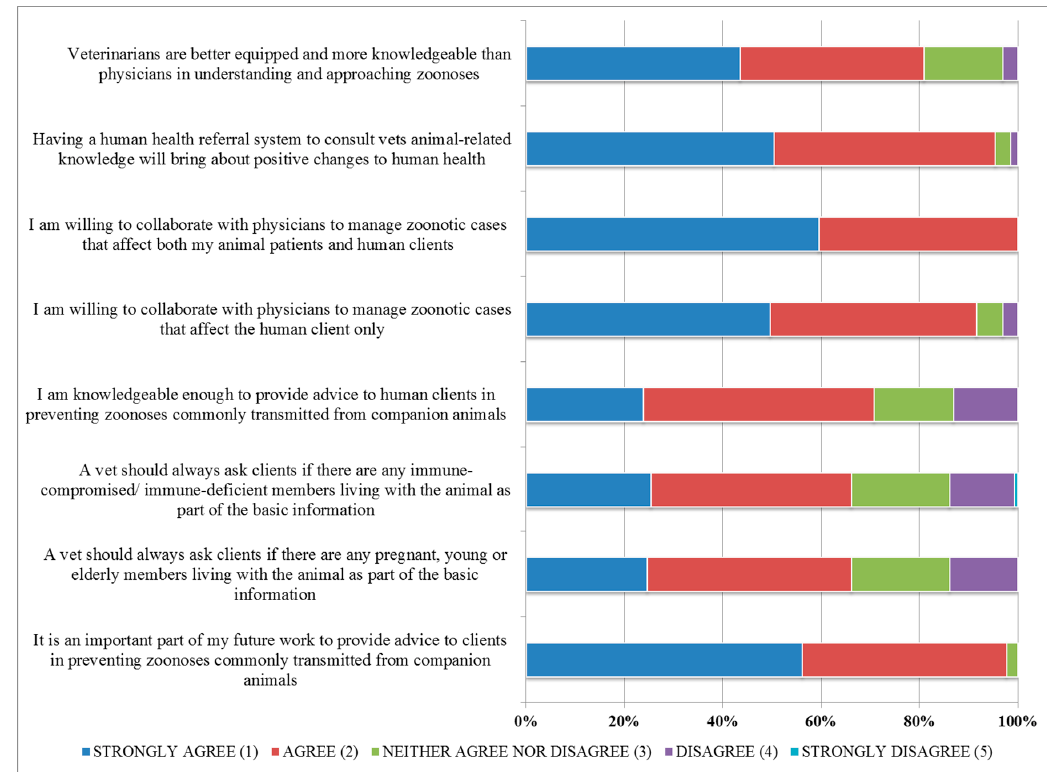
Figure 2. Perceived opinions expressed by 175 senior veterinary student respondents on interprofessional collaboration at the animal–human interface.